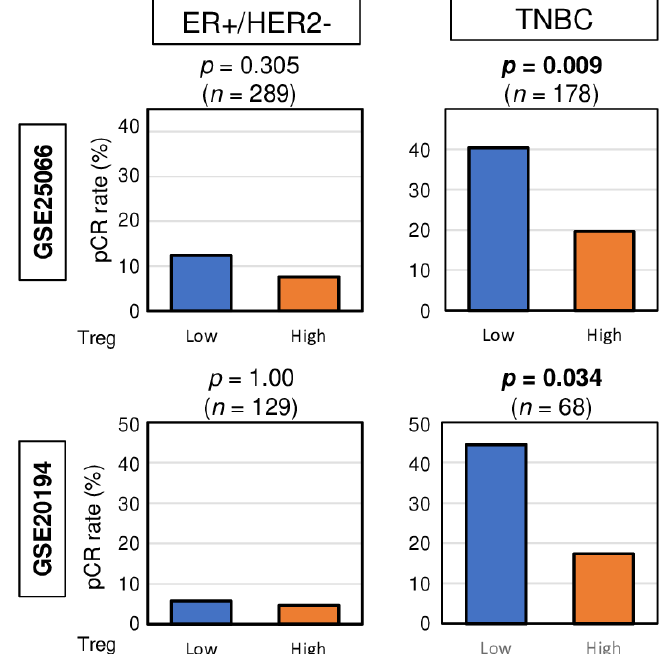
Figure 4. Bar plots depicting the pCR rates between low and high abundance of Treg groups among patients with ER-positive / HER2-negative tumors and TNBCs in the GSE25066 ( n = 508) and GSE20194 ( n = 248) cohorts. These cohorts were chosen because of their response to neoadjuvant chemotherapy data. Fisher’s exact test was used for the analysis.